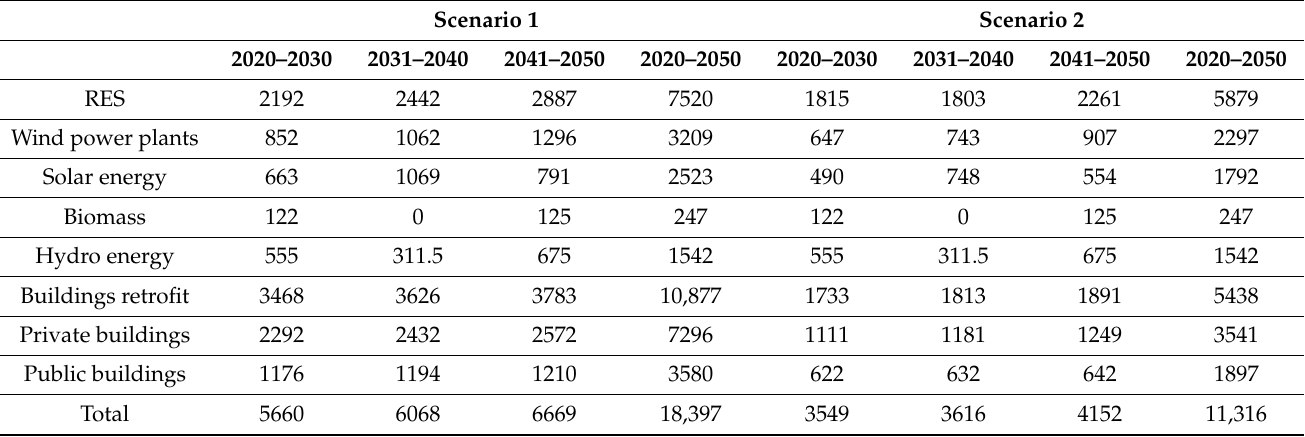
Table 1. Investments required for successful energy transition by two scenarios, in million